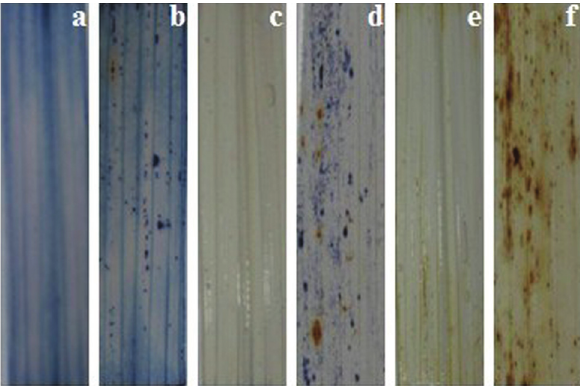
Figure 4 - Photographs of leaves stained with Trypan blue, NBT and DAN.Trypanblue:(a)wild-typeand(b) spl30 ;NBT:(c)wild-typeand(d) spl30 ; DAB: (e) wild-type and (f) spl30.